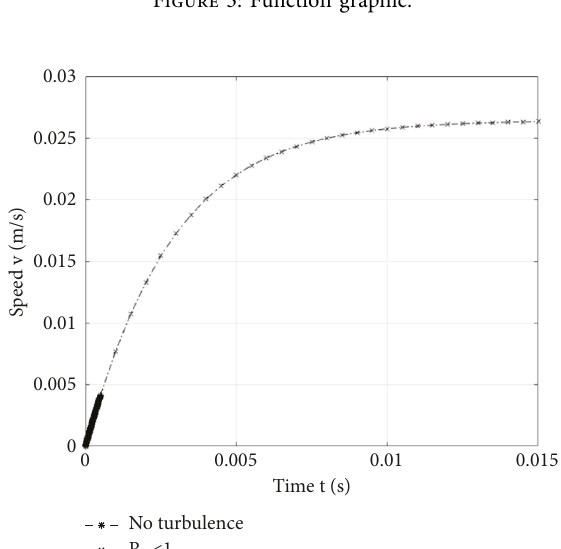
Figure 3: Function graphic.